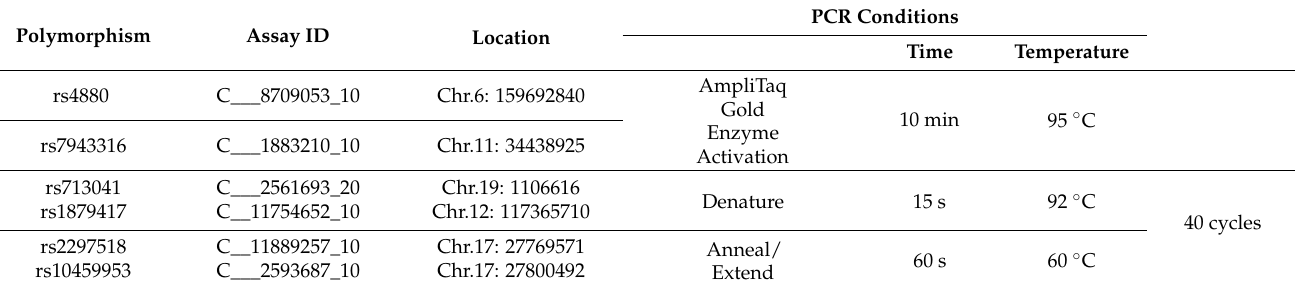
Table 2. TaqMan ® SNP Genotyping Assays used in this